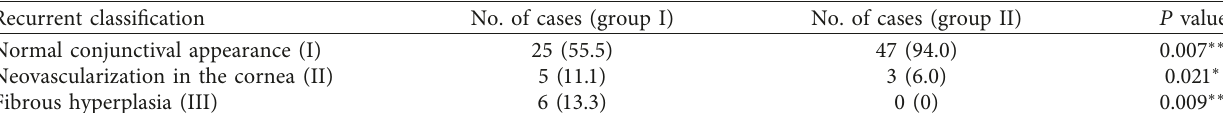
Table 2: Number of recurrences of pterygium patients in group I (no MMC injection) and group II (MMC